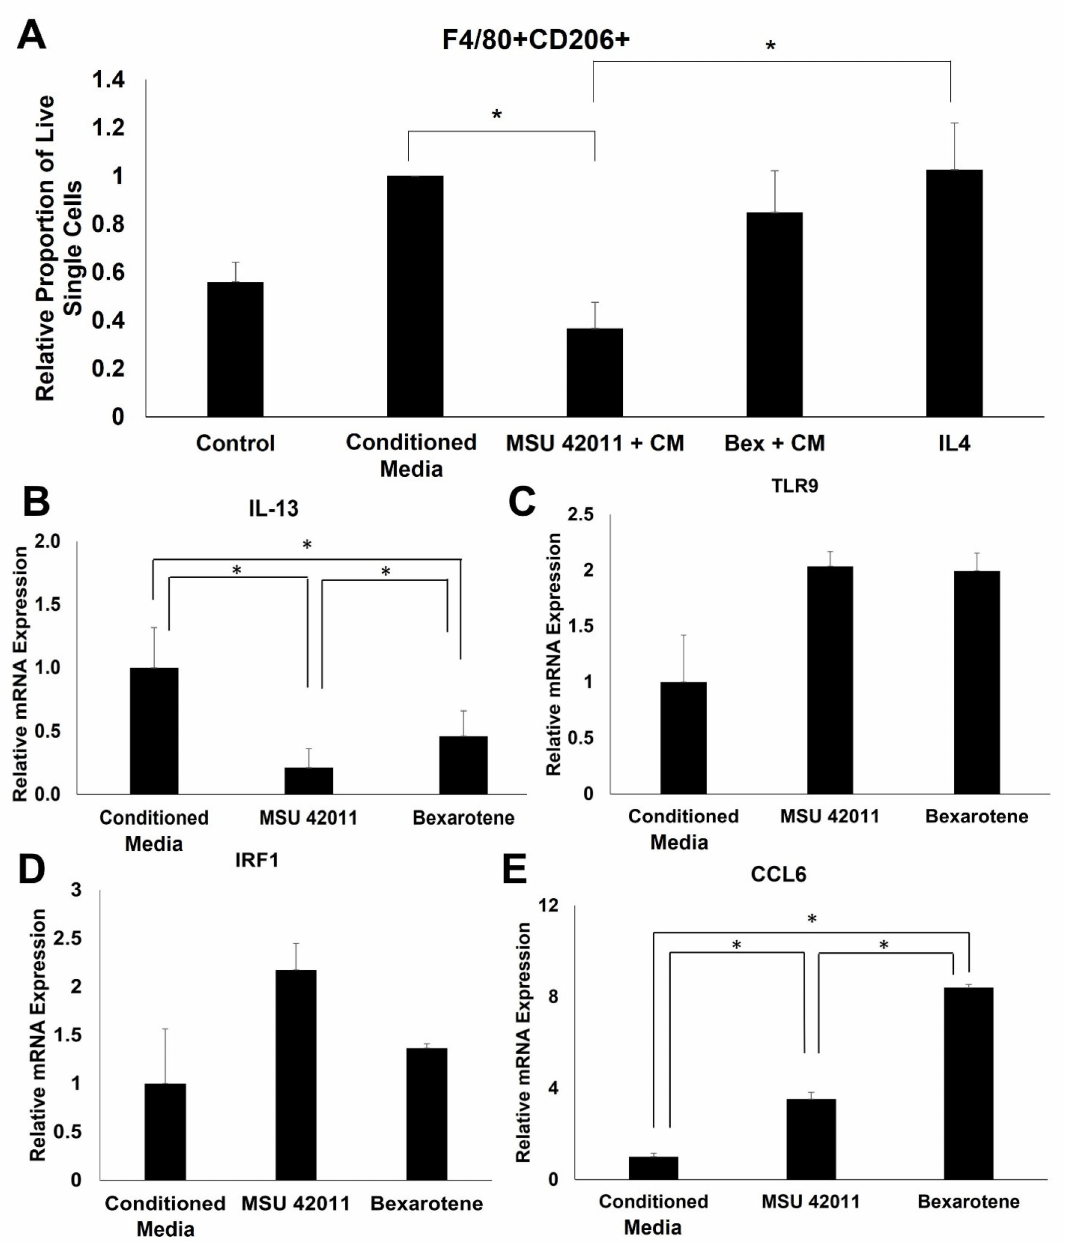
Figure 7. MSU-42011 polarizes bone marrow-derived macrophages (BMDMs) towards an anti-tumor phenotype. BMDMs were isolated from C57BL/6 mice and differentiated with MCSF. On day 5, BMDMs were treated with conditioned media (CM) from E18-14C-27 cells, either alone or with 300 nM RXR agonist. ( A ) BMDMs were harvested for flow cytometry to detect percentage of live single cells that were F4/80 + CD206+. All data normalized to conditioned media-treated cells and presented as mean of three experimental runs. Error bars represent standard error. ( B – E ) RNA was extracted, and gene expression was detected by qPCR. Error bars represent standard error of three biological replicates. * p <